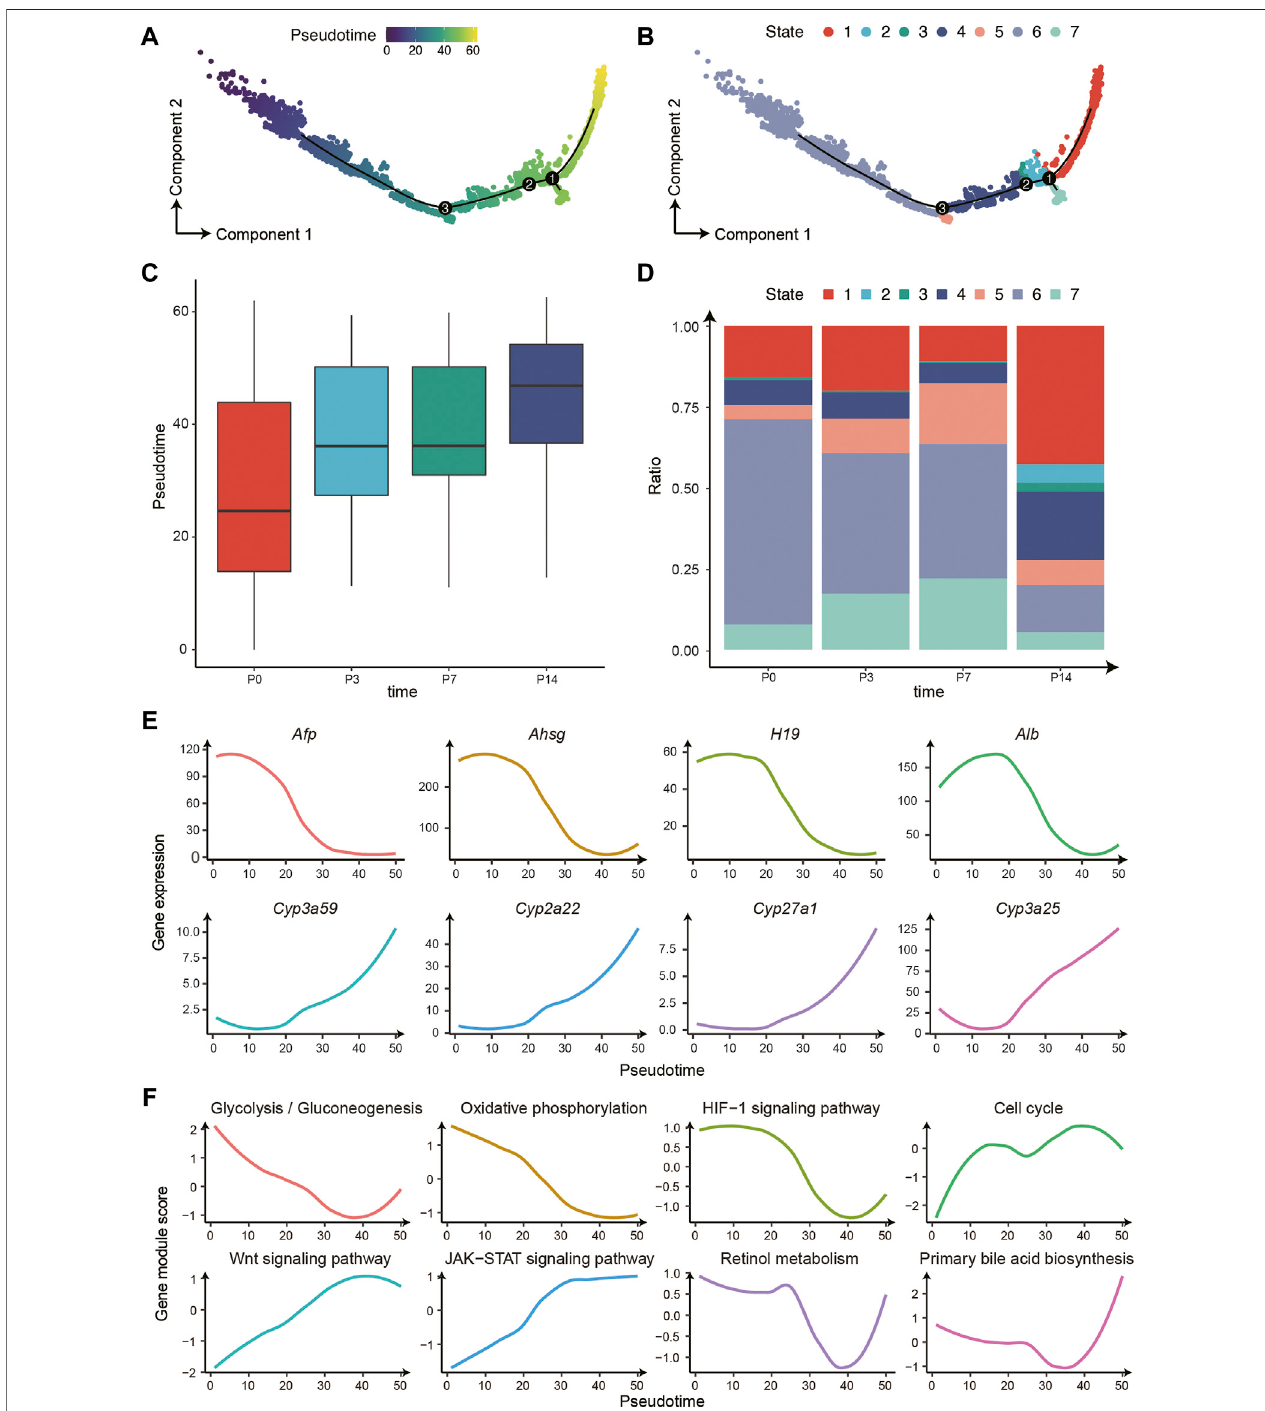
FIGURE 3 | The differentiation trajectory of hepatocytes. (A) The trajectory of hepatocyte development from P0 to P14 with Monocle 2. The colors from blue to yellow indicate an increased pseudotime. (B) The trajectory is the same as (A) . The colors represent 7 different states. (C) The boxplot for the pseudotime distribution in four time points. (D) The histogram displayed the hepatocyte numbers of 7 states in four time points. (E) The gene expression changes patterns along the trajectory. (F) The pathway changes patterns along the trajectory.